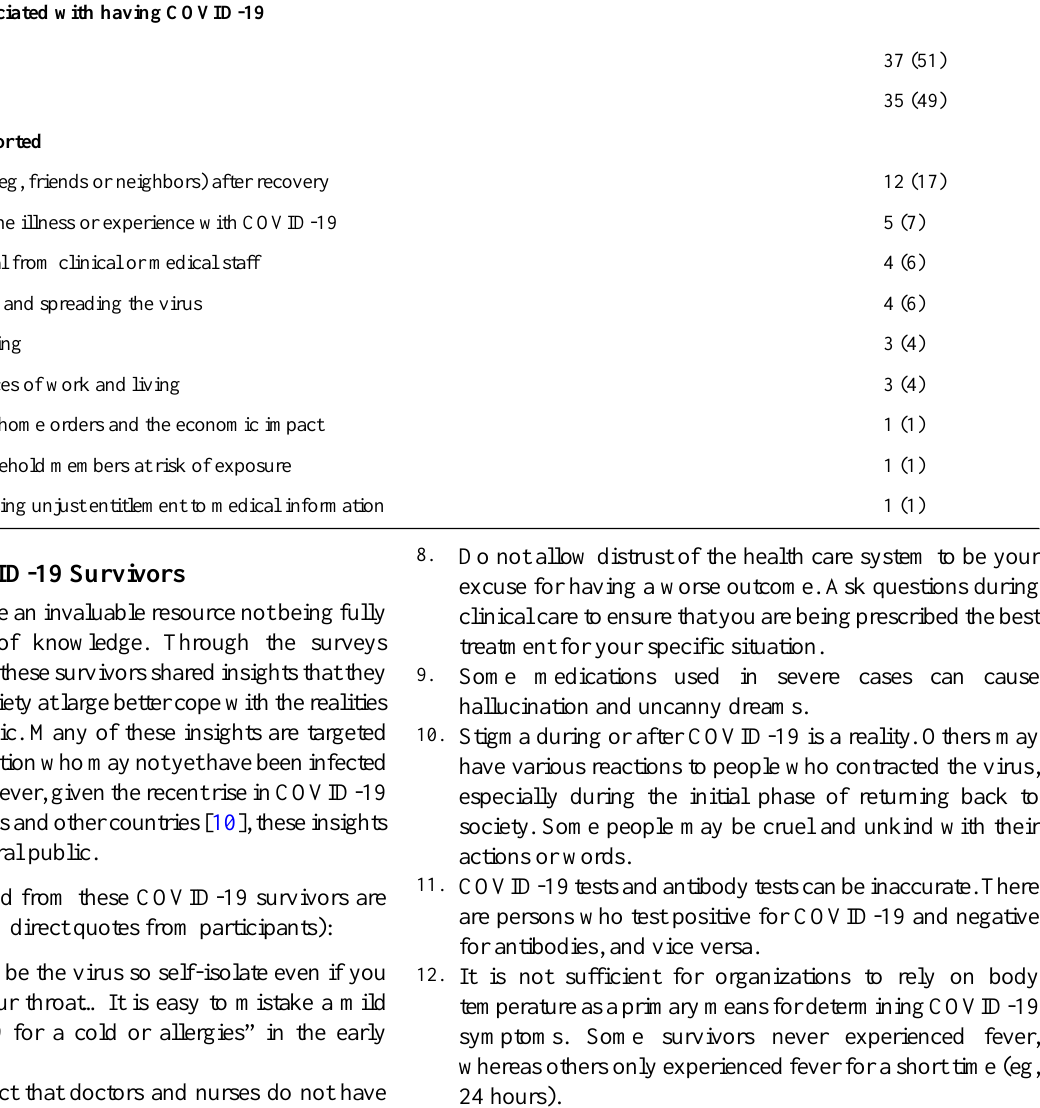
PrioleauJMIR FORMATIVE Table 2. Experience with stigma reported by participants (ie, COVID-19 survivors) in the C19 Insider Scoop Study (N=72). Experienced stigma associated with having COVID-19